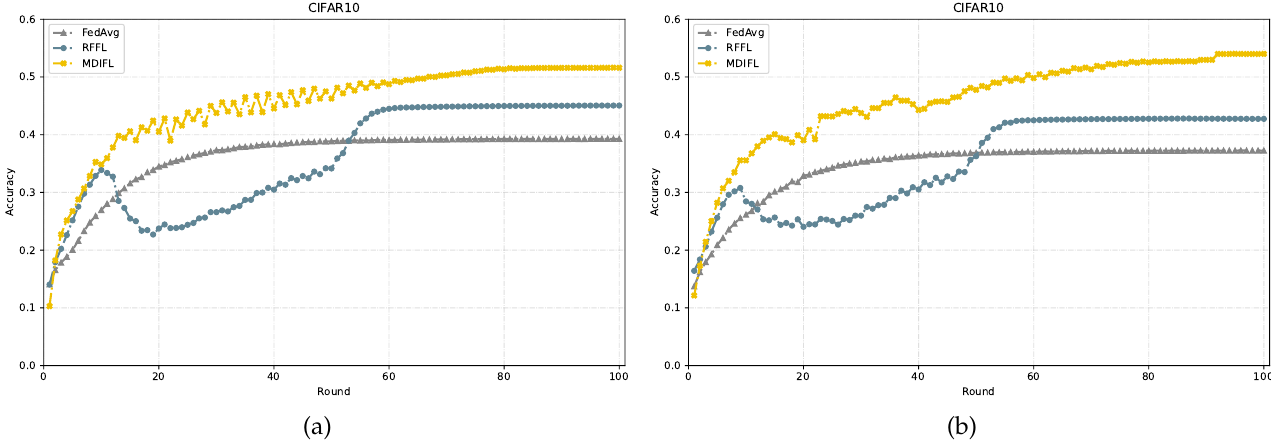
Figure 7. Accuracy comparison of MDIFL, FedAvg and RFFL. ( a ) Ten honest participants and 110% of S_P under UNI split CIFAR10. ( b ) Ten honest participants and 110% of S_P under POW split